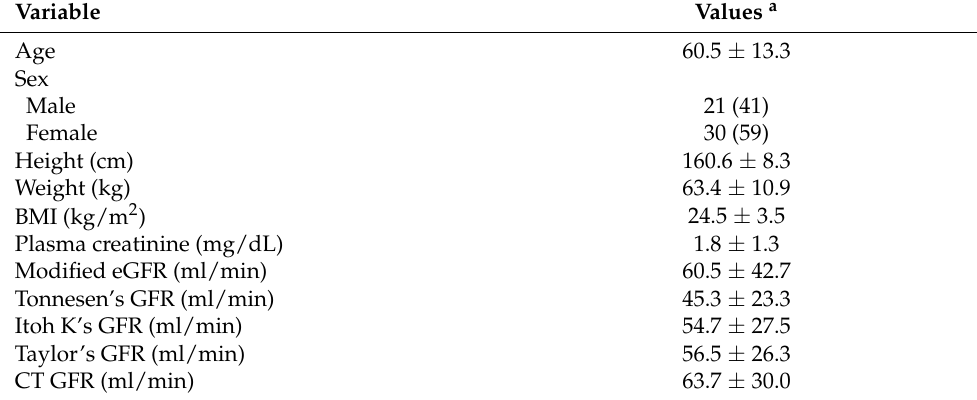
Table 1. Clinical characteristics of 51 patients enrolled in this study.